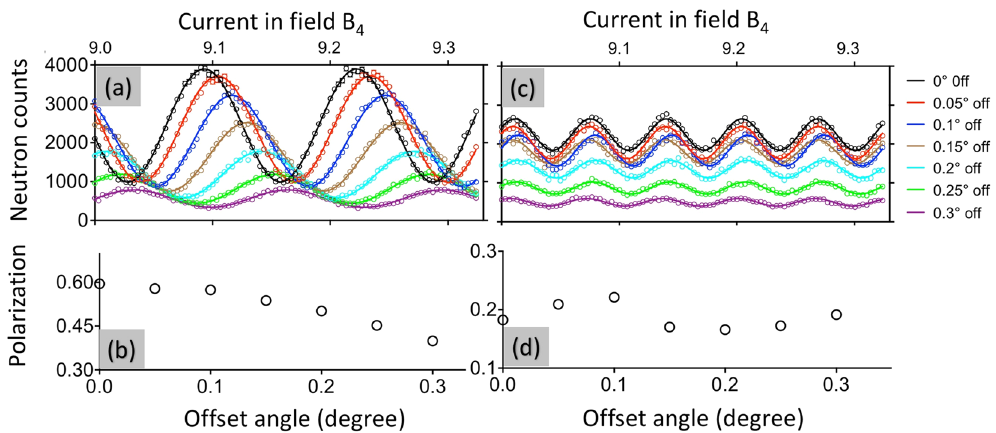
Figure 8. ( a ) and ( c ) are the fringes measured at various rocking angles for single-arm and double-arm configurations. The dot and solid curves are measured points and their fits respectively. ( b ) and ( d ) are the polarizations for single and double arm respectively obtained by fitting the fringes. The left side of the figure is for the single-arm configuration while the right side is for the double-arm configuration. The rocking angles are indicated on the right of the